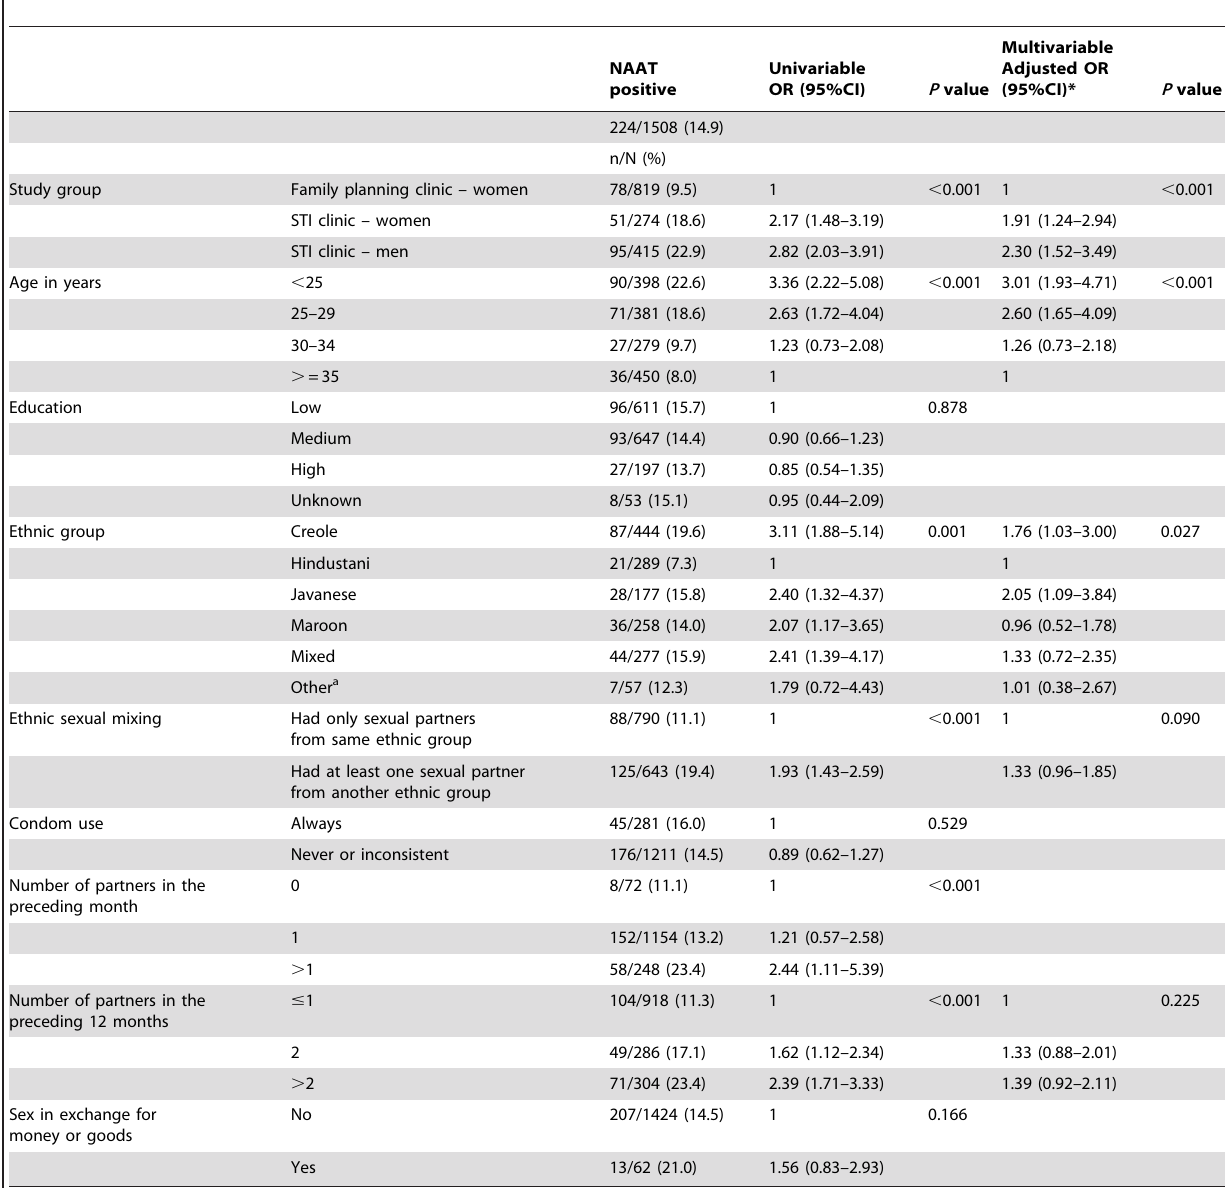
Table 2. Univariable and multivariable logistic regression analyses of determinants associated with chlamydia among the study population included at two sites in Paramaribo, Suriname,